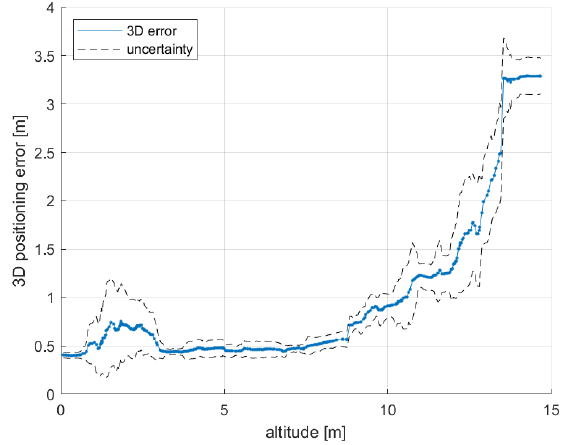
Figure 7. 3D positioning error varying the drone altitude. The error in Figure 7 increases significantly after 10 meters of altitude. Such increase is mostly determined by large height errors, as show in Figure 8.